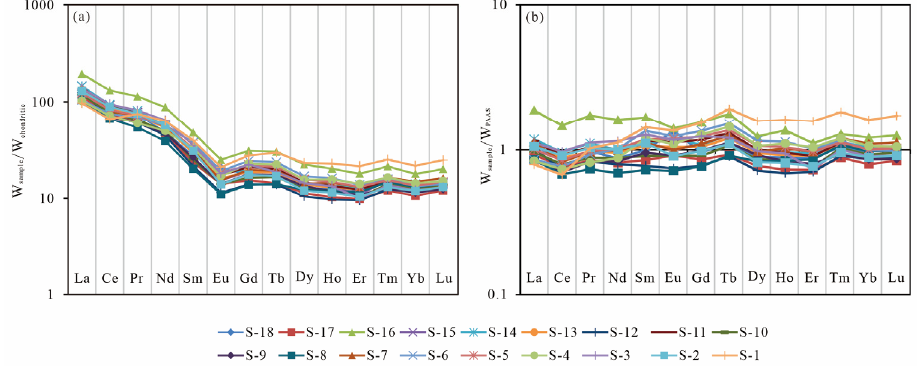
Figure 2. Normalised spider diagram of REEs in Longmaxi-1 black shales. ( a ) Normalised spider diagram of chondritic meteorites; ( b ) normalised spider diagram of PAAS.